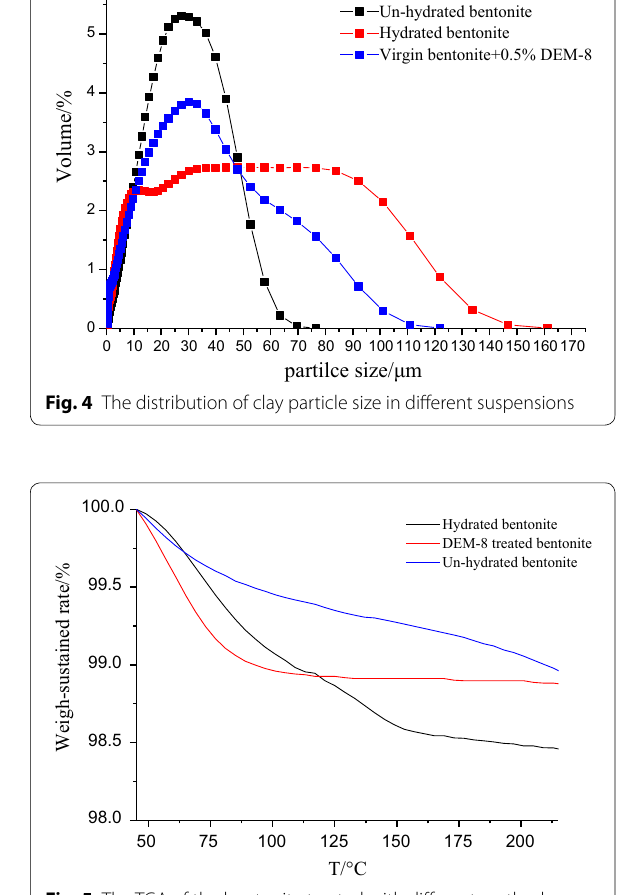
Fig. 5 The TGA of the bentonite treated with different methods